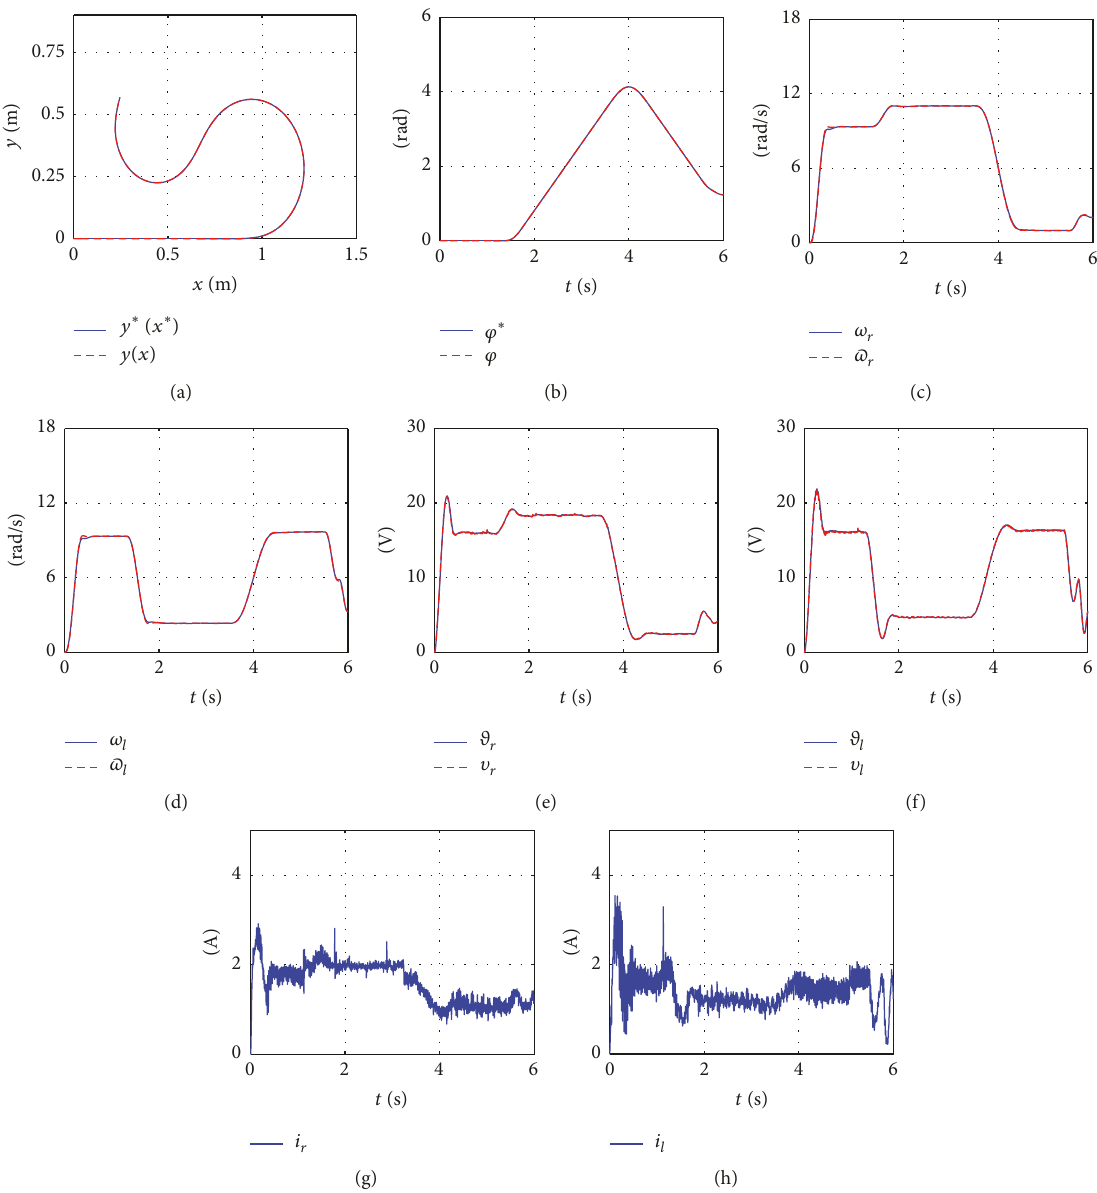
Figure 5: Experimental results when uncertainties exist in 𝑅 𝑟 and 𝑅 𝑙 .